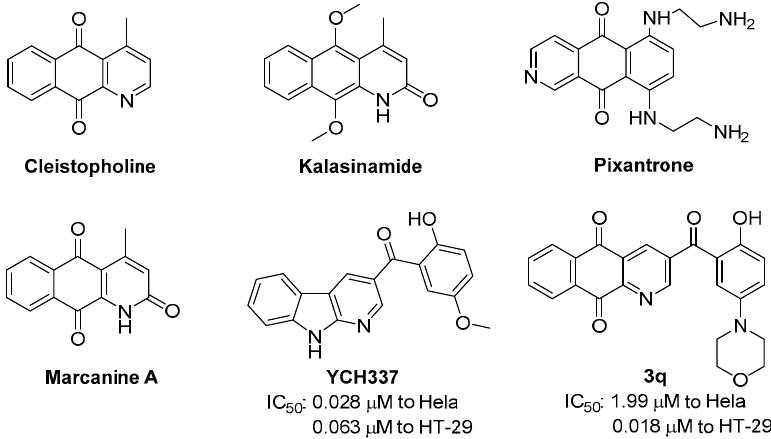
Figure 1. Biologically active aza-anthraquinone derivatives and YCH337.